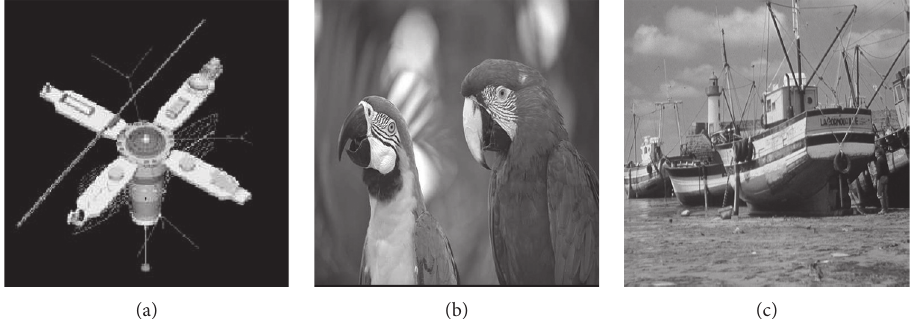
Figure 18: Original images. (a) Satellite (256). (b) Macaws (512). (c) Boat (1024).